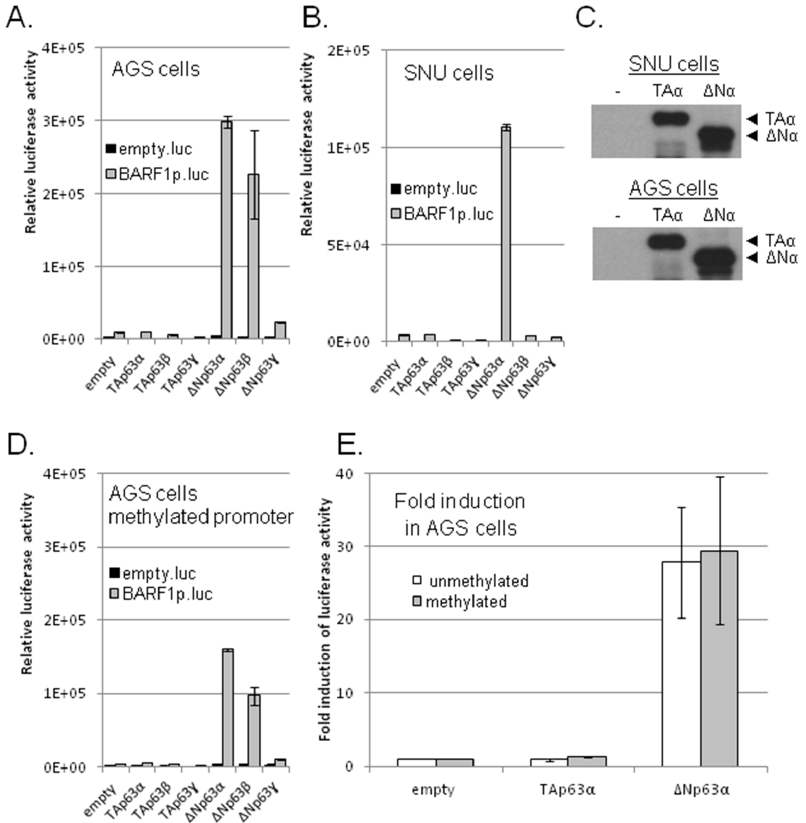
Figure 2. The BARF1 promoter reporter construct is transactivated by the Δ Np63 α isoform. ( A ) Representative graphs of a cotransfection of the reporter construct with individual p63 isoforms in AGS and ( B ) SNU-719 cells. Only the Δ Np63 α isoform shows transcriptional activity in both cell lines; ( C ) Representative SDS-page Westernblot of both the TAp63 α and Δ Np63 α isoform demonstrates comparable protein levels; ( D ) Methylation of the BARF1 promoter reduces relative luciferase activity induced by Δ Np63 α , representative graph; ( E ) Luciferase activity is 28 fold upregulated by Δ Np63 α and not by TAp63 α ( n = 7). Fold induction induced by Δ Np63 α compared with constitutive activity of the methylated promoter is unchanged (29 fold) ( n =